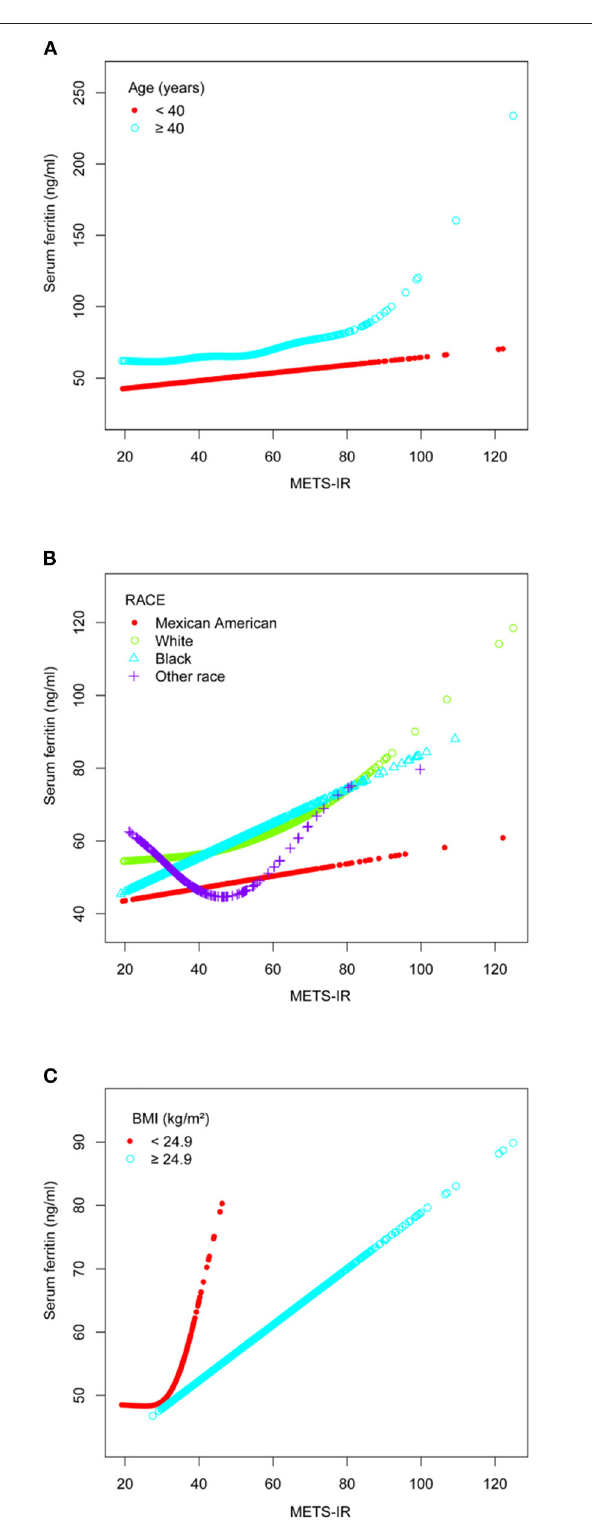
FIGURE 3 | The association between METS-IR and serum ferritin. (A) Stratified by age (years). (B) Stratified by race. (C) Stratified by BMI (kg/m 2 ). All the covariates in Table 1 were adjusted. In the subgroup analysis stratified by each covariate, the model is not adjusted for the stratification variable itself.